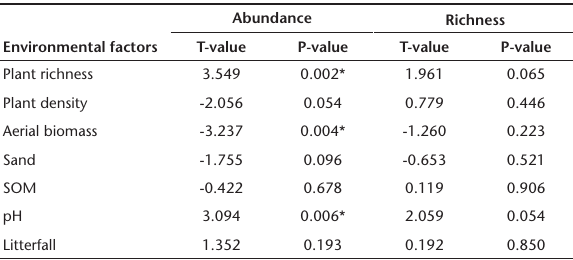
Table 2. Results of multiple regressions between epiedaphic Collem- bola abundance (R 2 : 59%, R 2 : 43%, P-value: 0.011) and richness adj (R 2 : 29%, R 2 : 1.7%, P-value: 0.424) and environmental variables adj recorded in João Câmara, Rio Grande do Norte, Brazil, in 2011. SOM: soil organic matter.